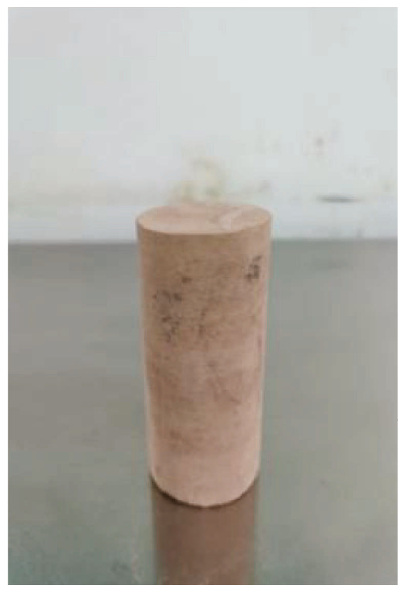
Figure 4: Mudstone